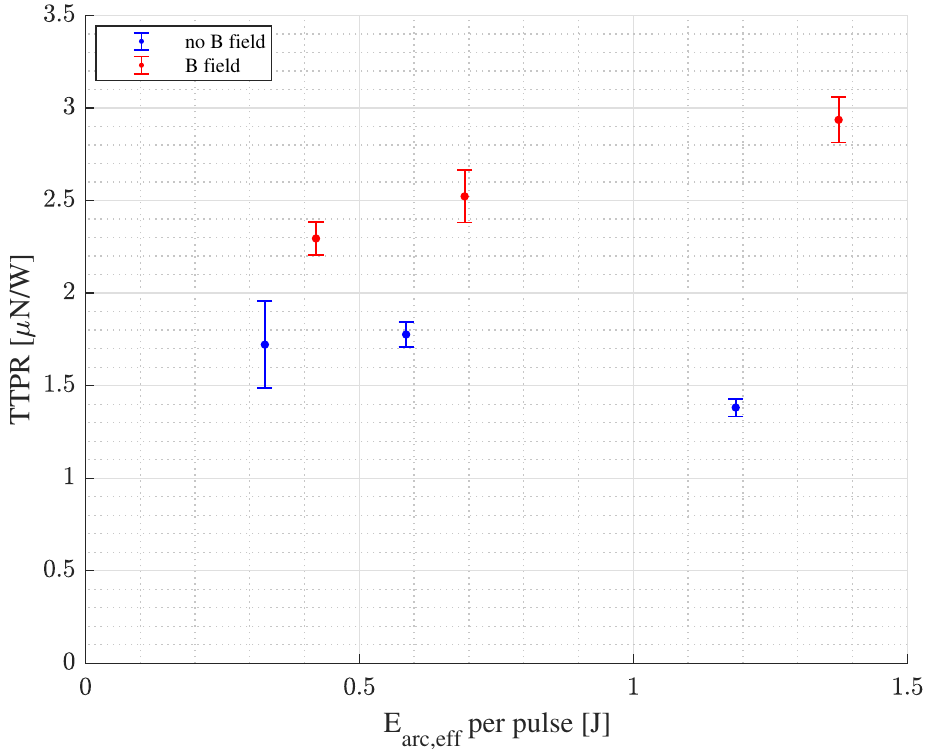
Figure 8. Thrust to power ratios (TTPR) values for different dissipated arc energies. The errorbars indicate the measurement uncertainty obtained from the error propagation